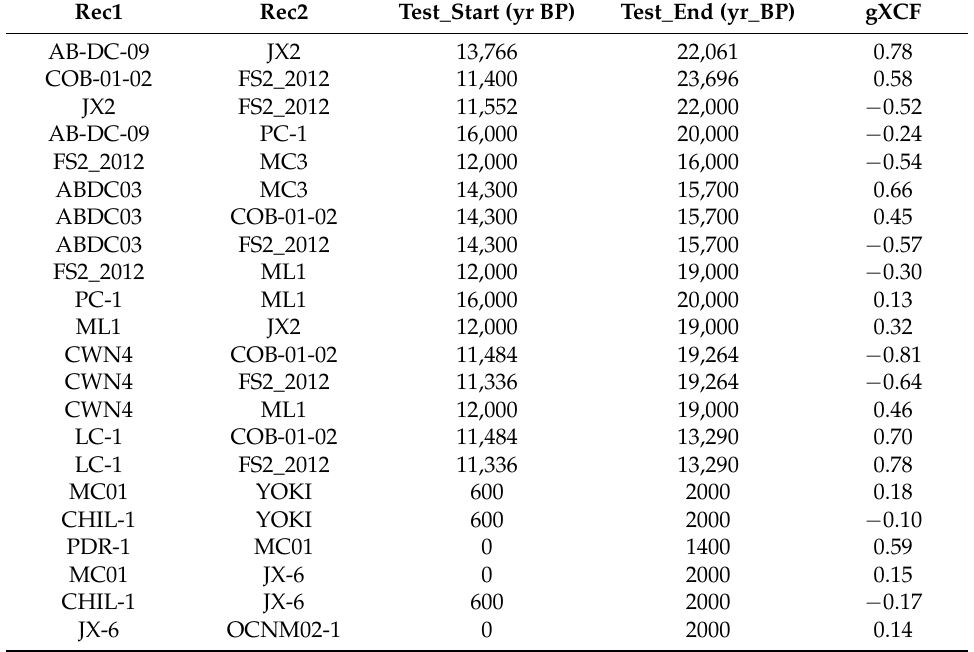
Table 2. Timing of overlap and gXCF values for significant pairwise correlations between speleothem records for the LGM-deglacial and last 2000-year time